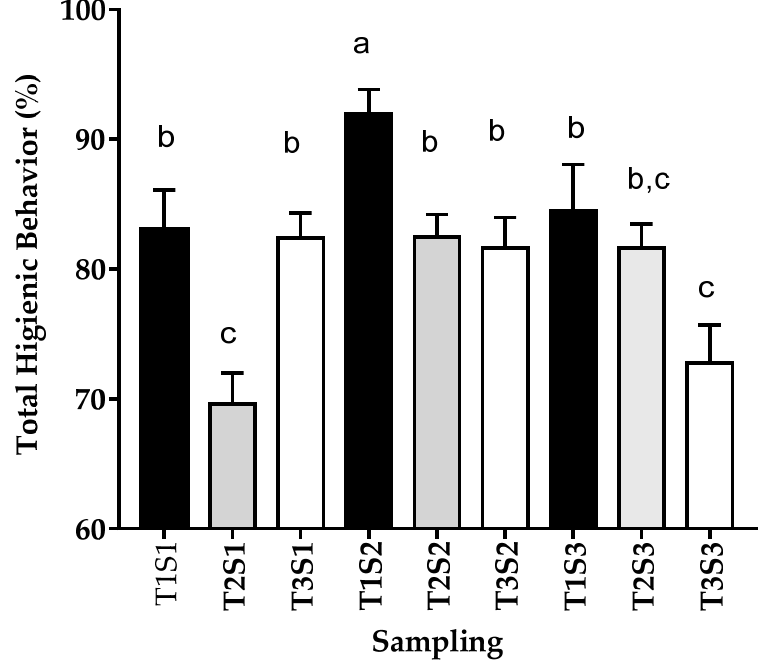
Figure 1. Hygienic behavior in each period of evaluation of colonies as a function of the different altitude levels of the central highlands of Ecuador. Samples were collected in March–April (before honey production, S1), May–July (during production, S2), and August–September (after production, S3). The data were divided into three altitude tiers 2600–2800 [T1], 2801–3000 [T2] and higher than 3000 [T3] meters above sea level (m.a.s.l). Data represent means ± SEM (hives/sampling: T1 n = 15, T2 n = 35, T3 n = 25). Different letters denote significant differences between the groups (Bonferroni). This difference may be attributed, among factors, to the different stages undergone by the colonies during the samplings (before, during, and after production), as well as environmental changes taking place throughout the